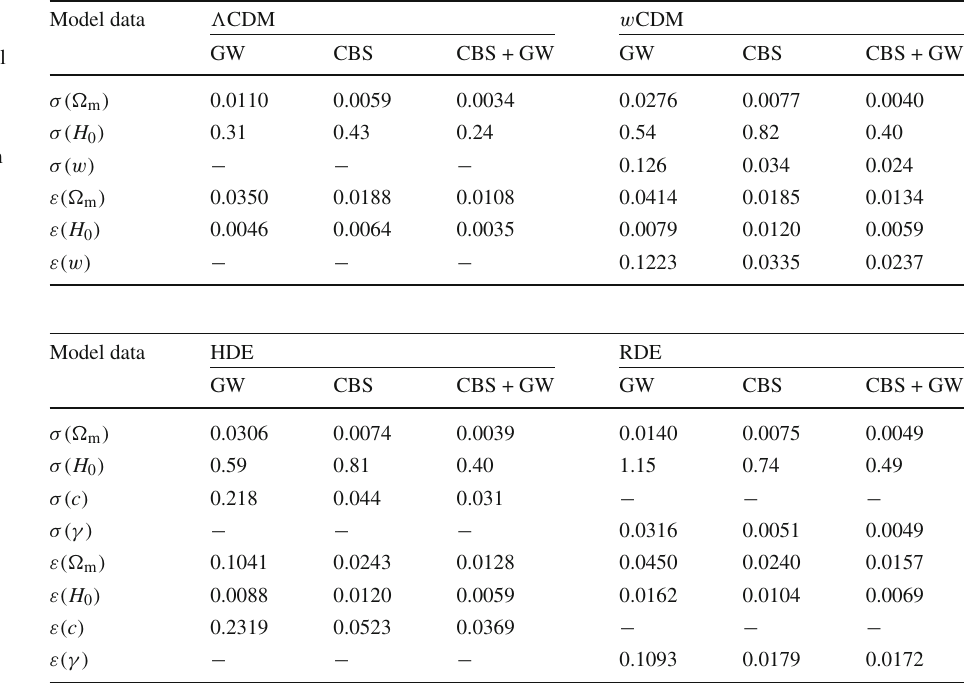
accuracies for cosmological parameters of the (cid:3) CDM model and the w CDM model using GW, CBS, and CBS + GW. Here, CBS stands for CMB +